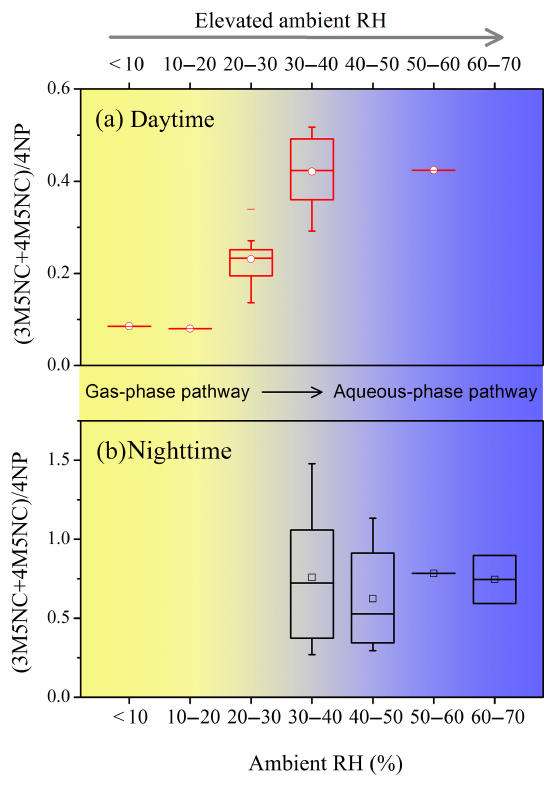
Figure 9. (3M5NC + 4M5NC) / 4NP concentration ratio as a func- tion of ambient RH during (a) daytime and (b)